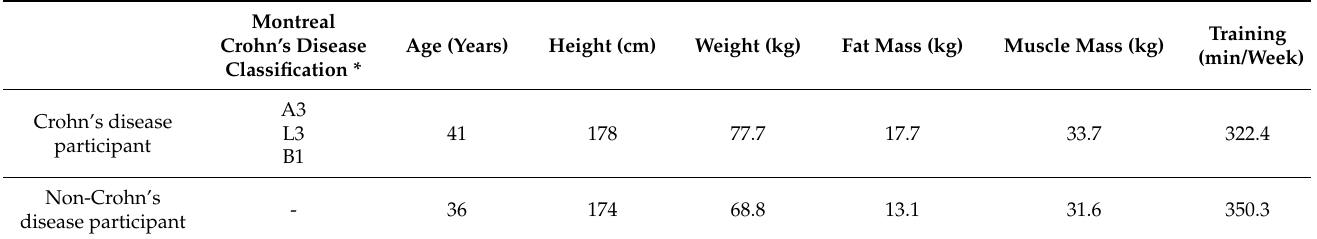
Table 1. Main characteristics of the participants with and without Crohn’s Disease.